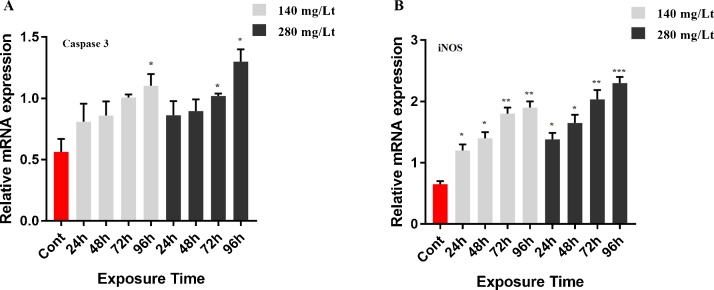
Effect of 140 mg/L and 280 mg/L doses of IMI exposure on mRNA transcript levels of caspase-3 and iNOS in the brain of Common Carp. Values represent the mean ± SD of 3 indipendent samples; error bars indicate standard deviation. Statistical significance (* P ˂ 0.05, ** p < 0.01, *** p < 0.001) was analyzed using a factorial ANOVA. A) Represent the relative mRNA expression levels of caspase-3. B) Represent the relative mRNA expression levels of iNOS.